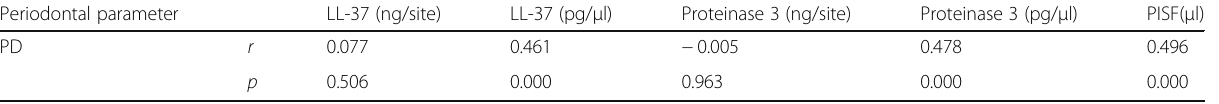
Table 2 Correlations between PD of sampling site and PISF LL-37 and proteinase 3 levels Periodontal